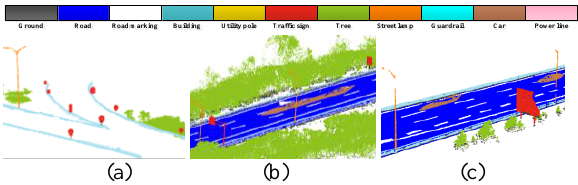
Figure 11. Details of the roadside objects extraction results: (a) small size traffic signs, (b) moving cars, and (c) incomplete street lamps, traffic signs and cars.